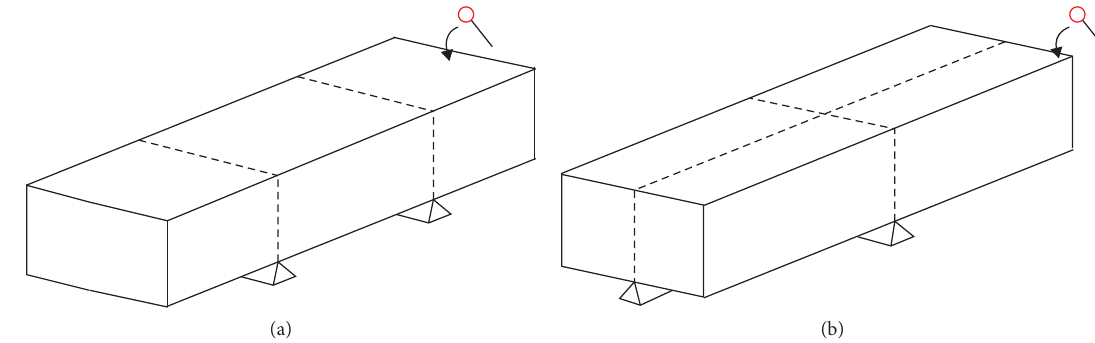
Figure 7: IET setup for flexural (a) and torsional (b) mode